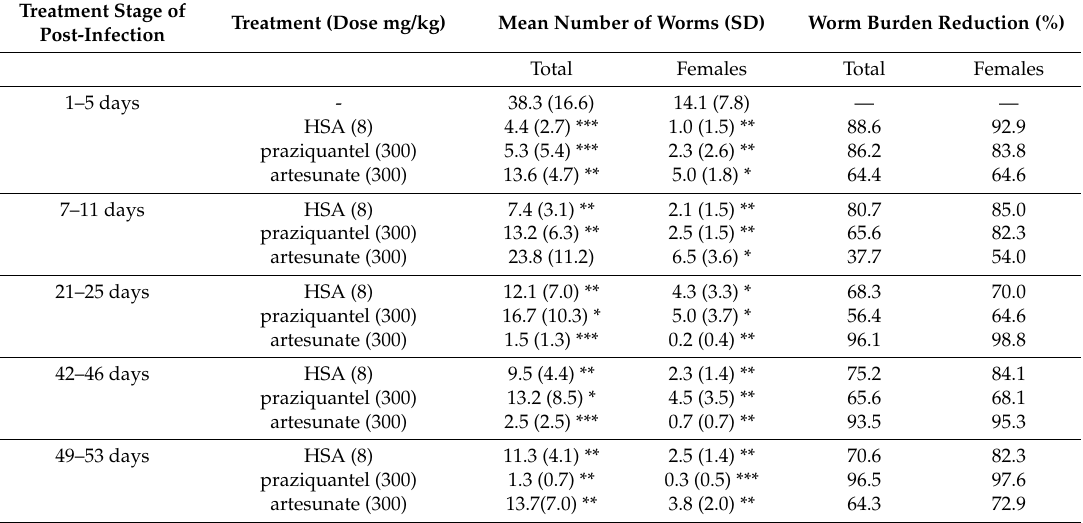
Table 3. Stage-specificity of a single 8 mg · kg − 1 dose HSA, praziquantel or artesunate was administered to mice infected with S. mansoni .